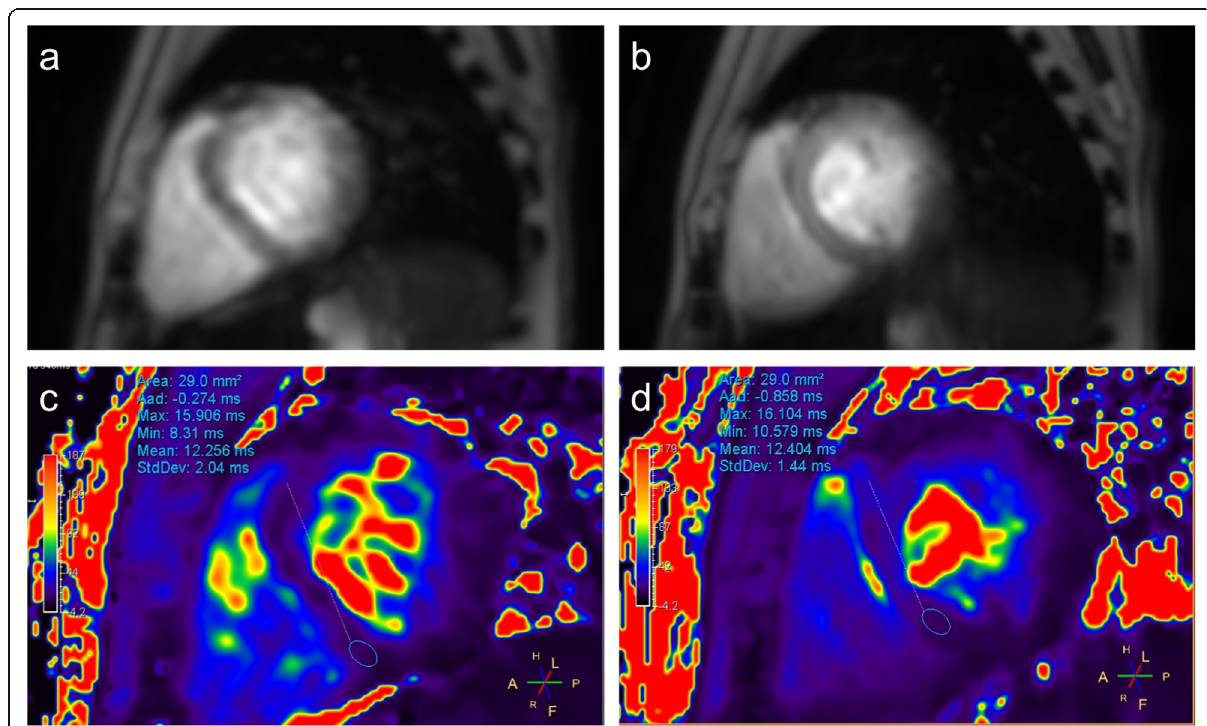
Fig. 5 Multi-phase turbo field-echo images and T2* maps of a 9-year old boy affected with a β -thalassemia. a Original image obtained using the breath-holding technique. b Original image obtained using the free-breathing technique. c T2* map obtained using the breath-holding technique. d T2* map obtained using the free-breathing technique